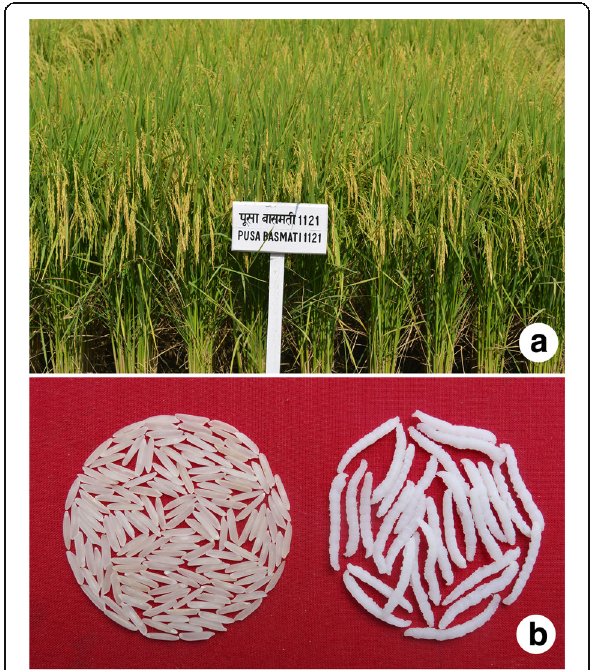
Fig. 3 a Field view of the plot of PB 1121 at ICAR-IARI, New Delhi, ( b ) Milled rice and cooked rice kernels of PB